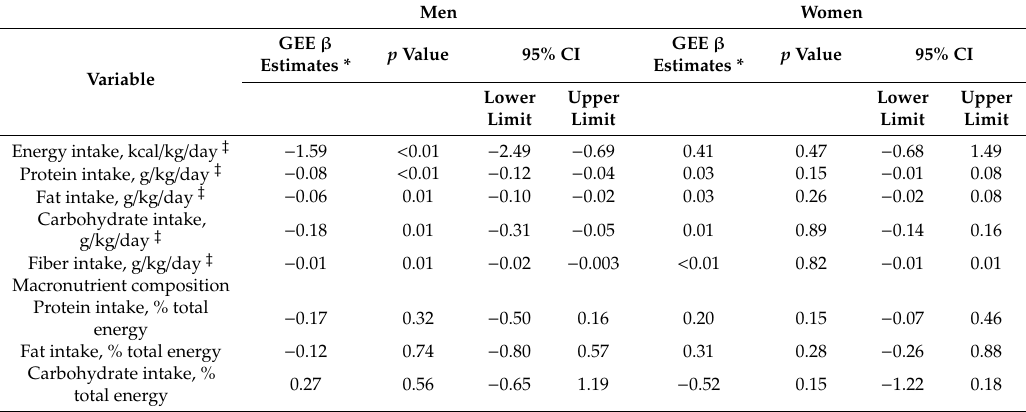
Table 2. Longitudinal nutrient intake changes in men and women with social prefrailty or frailty compared to the socially robust group †